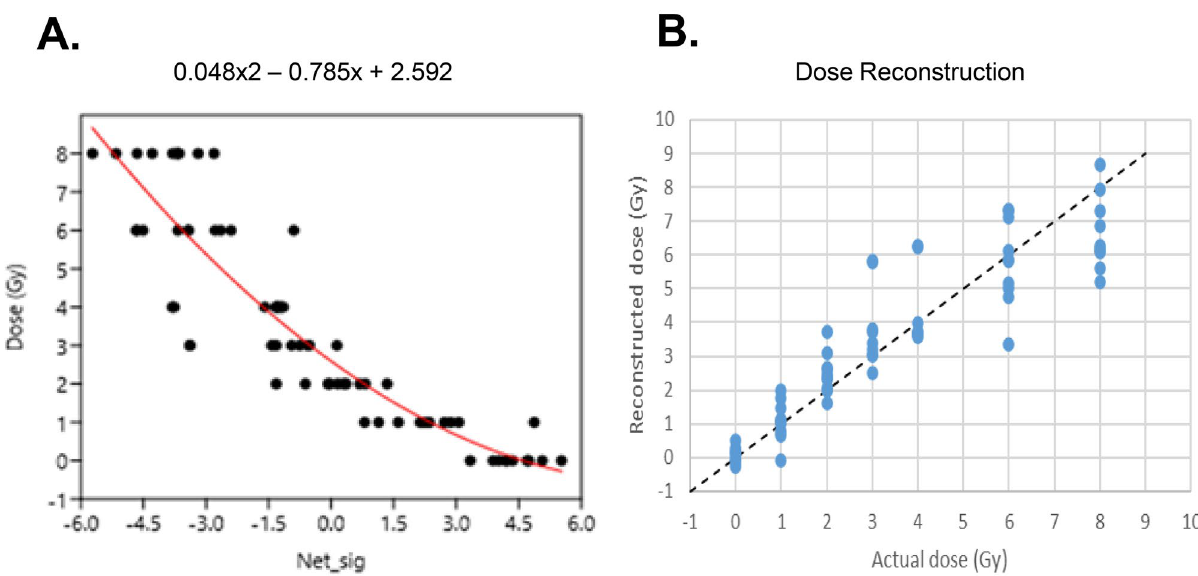
Figure 6. Dose reconstruction in the independent mouse cohort using qRT-PCR. ( A ) Plot of the best-fitting regression equation ( B ) plot of reconstructed dose versus actual dose, which was used to determine